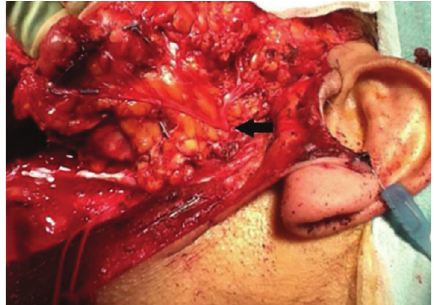
Figure 2: Careful dissection revealing the branches of the facial nerve which were preserved. The facial nerve passes through the parotid gland after emerging from the stylomastoid foramen. The arrow points to the point of division into five branches: temporal, zygomatic, buccal, marginal mandibular, and